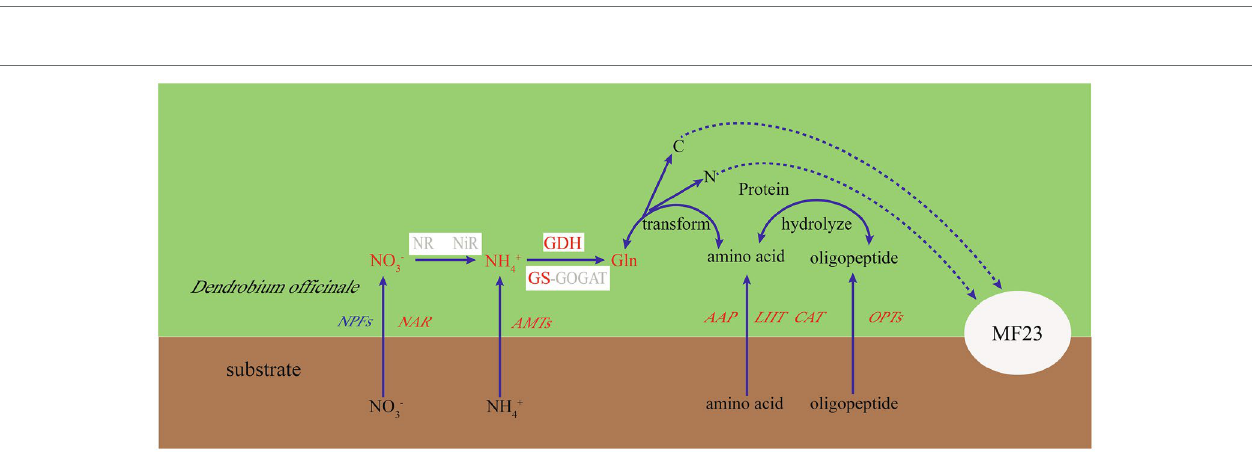
FIGURE 6 | Effects of fungus MF23 on key enzyme activity of nitrogen assimilation in D. officinale ( n = 3). (A) Nitrate reductase (NR) activity. (B) Nitrite reductase (NiR) activity. (C) Glutamine synthetase (GS) activity. (D) Glutamate synthase (GOGAT) activity. (E) Glutamate dehydrogenase (GDH) activity. AC, axenic culture and DC, dual culture. * p < 0.05; ** p < 0.01.